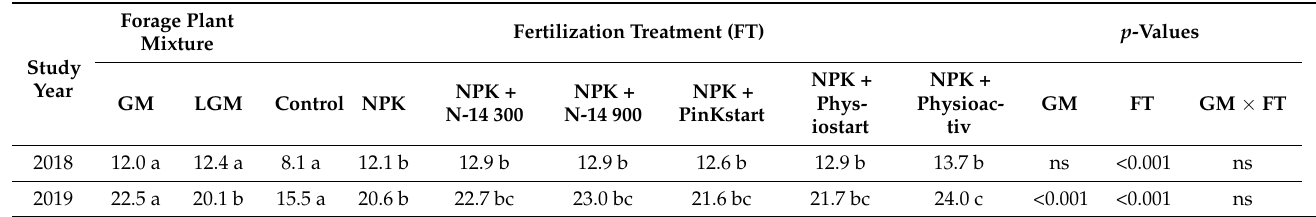
Table 2. Effect of forage plant mixture type and fertilization treatment on total biomass yields (t · ha − 1 FM). Forage Plant Mixture Study Year